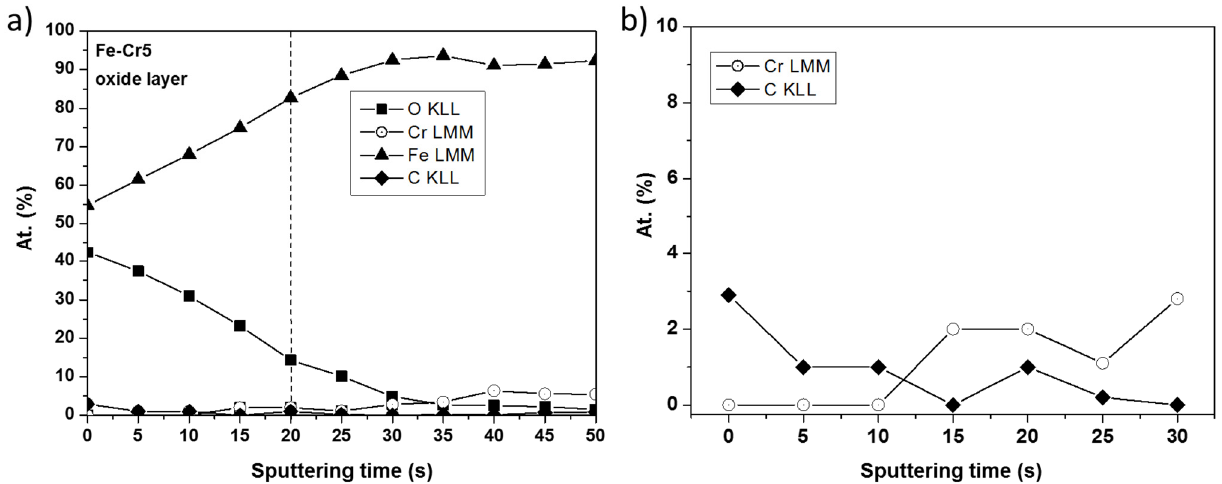
Figure 7. Distribution of elements Fe, Cr, O, C in anodic layer formed on alloy Fe-5% Cr after chronoamperometric measurements: ( a ) the full sputtered thickness, ( b ) the sputtered thickness corresponding principally to the oxide layer.